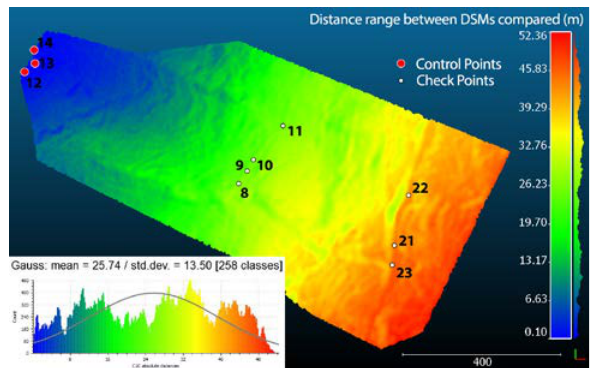
Figure 8. Scenario (b) Distance range comparison and Gauss curve fitting on distance difference histogram values(units in m) Min=0.10 / Max=52.36 / Mean=25.74 / Std.